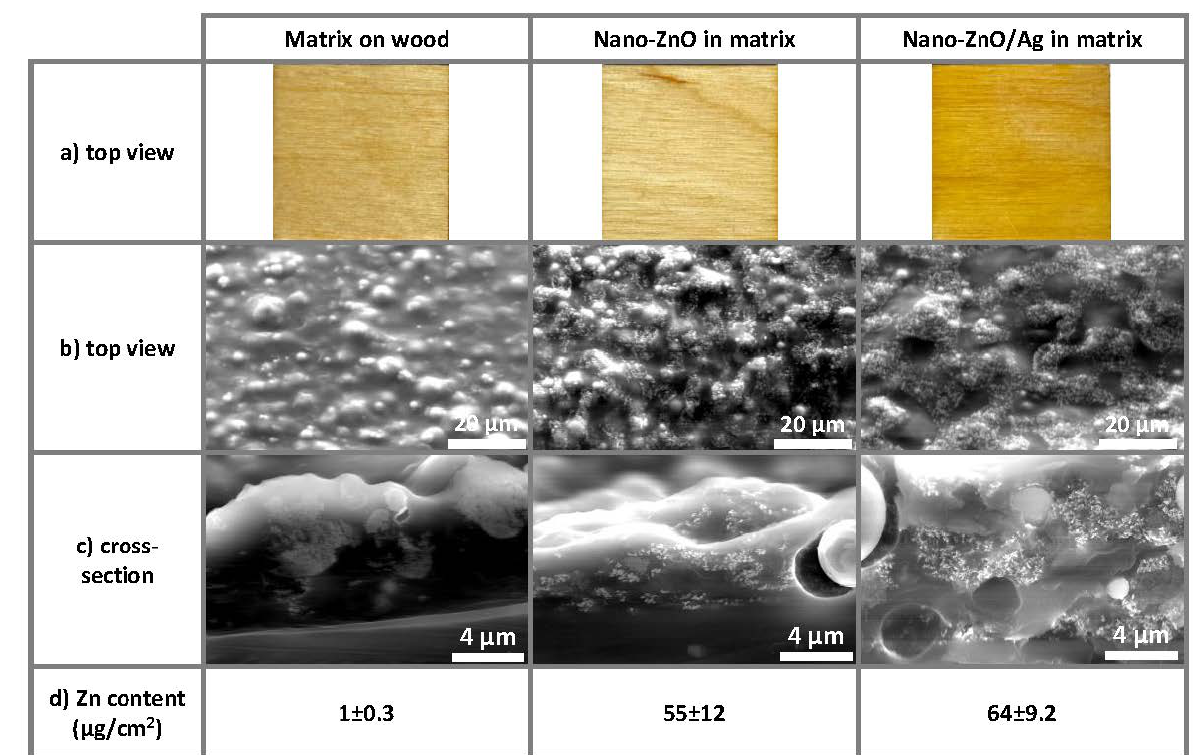
Figure 2. Photographic images, SEM images and XRF analysis data of coatings on wooden substrates: ( a ) photographic top view images of 25 × 25 mm samples reveal a more yellow coloring of nano-ZnO/Ag-based coatings compared to nano-ZnO-based and pure matrix coatings; ( b ) top view and ( c ) cross-section SEM images reveal a similar distribution for both nano-ZnO- and nano-ZnO/Ag-embedded nanoparticles; ( d ) Zn content ( µ g/cm 2 ) was determined using X-ray fluorescence spectroscopy. Zn content in both nanoparticle-based coatings was similar and notably higher compared to the control (pure matrix-covered substrate).